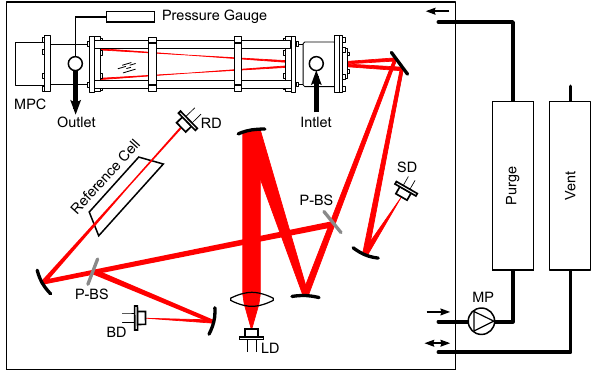
Figure 2. Example spectra of ISOWAT II showing the up and down scan across the absorption region of interest. Polynomial baseline Fig. 2: Example spectra of ISOWAT II showing the up and (green trace) of the direct absorption spectra (black trace) as well as down scan across the absorption region of interest. Poly- detector zero signal (blue trace) are used to normalize the second- nomial baseline (green trace) of the direct absorption spec- Fig. 2: Example spectra of ISOWAT II showing the up and harmonic absorption spectra (red trace). A is the peak-to-peak tra (black trace) as well as detector zero signal (blue trace) H 16 2 O down scan across the absorption region of interest. Poly- are used to normalize the second-harmonic absorption spec- amplitude of the strong H 16 O absorption line. The weak H 16 O line 2 2 nomial baseline (green trace) of the direct absorption spec- tra (red trace). A is the peak-to-peak amplitude of the used in humid conditions is depicted 20 × H 16 2 O tra (black trace) as well as detector zero signal (blue trace) O line used in strong H 16 O absorption line. The weak H 16 2 2 are used to normalize the second-harmonic absorption spec- humid conditions is depicted 20 enlarged. × tra (red trace). A is the peak-to-peak amplitude of the H 16 2 O O line used in strong H 16 O absorption line. The weak H 16 2 2 humid conditions is depicted 20 enlarged. ×